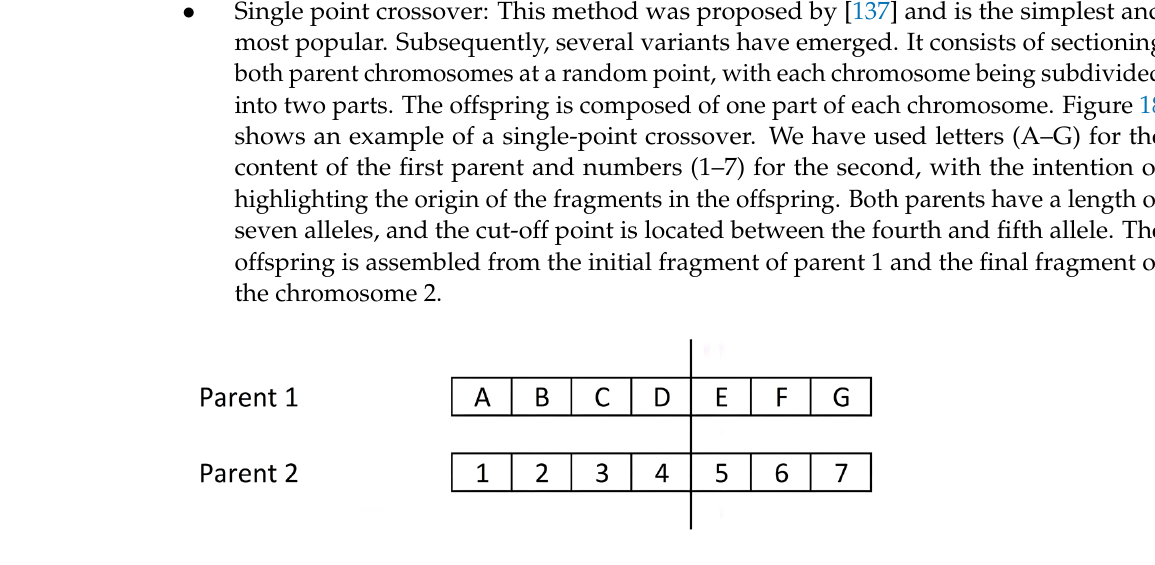
Depending on the coding used, sometimes not all points on a chromosome are suitable as cut points. This is the case of cutting at an intermediate point of a gene, possibly generating offspring with an invalid gene value. The repair function is responsible for solving conflicts in the viability of